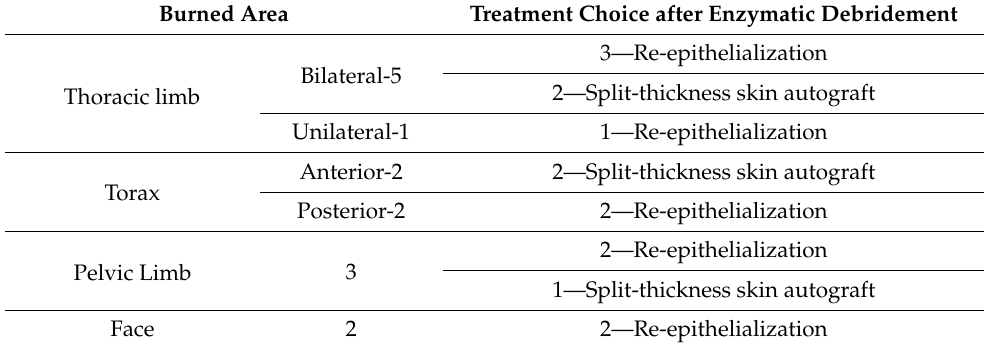
Figure 2. Modified intern protocol of enzymatic debridement. Table 2. Localization of burns and treatment choice after enzymatic